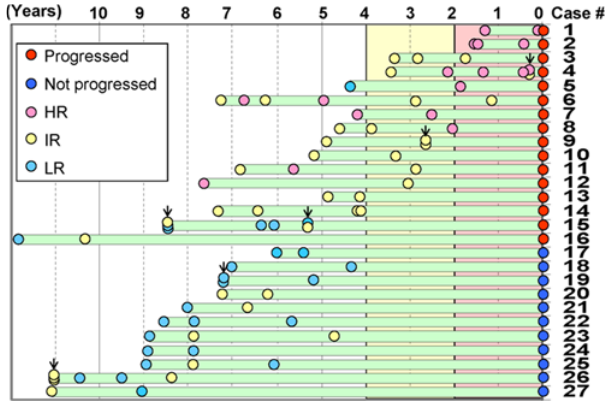
Figure 6. Changes in 3-risk-group prediction during follow-up. The horizontal axis represents the time interval preceding the date of progression or nonprogression. Among 62 patients, 27 patients underwent biopsies at multiple timepoints before progression. Each green bar represents the follow-up period of each patient, and each circle shows the timing of biopsies and the risk level prediction (designated by each circle’s color). Vertically overlapped circles with arrows indicate multiple tissue specimens obtained at a single endoscopy, while horizontally overlapped circles (no arrows) indicate specimens obtained at temporally neighboring but separate endosco- pies.